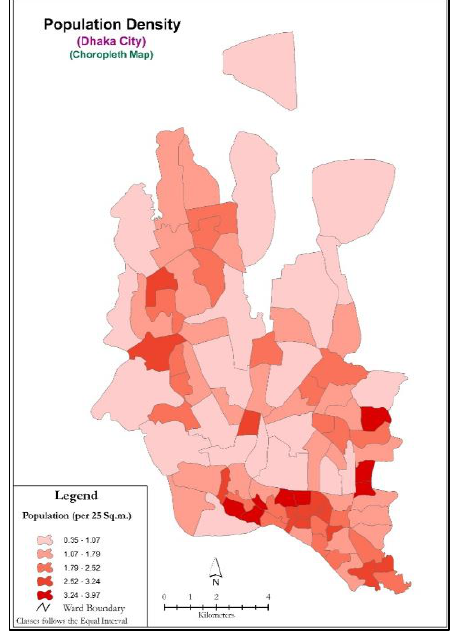
Figure 8. Output of the choropleth map of the study area.